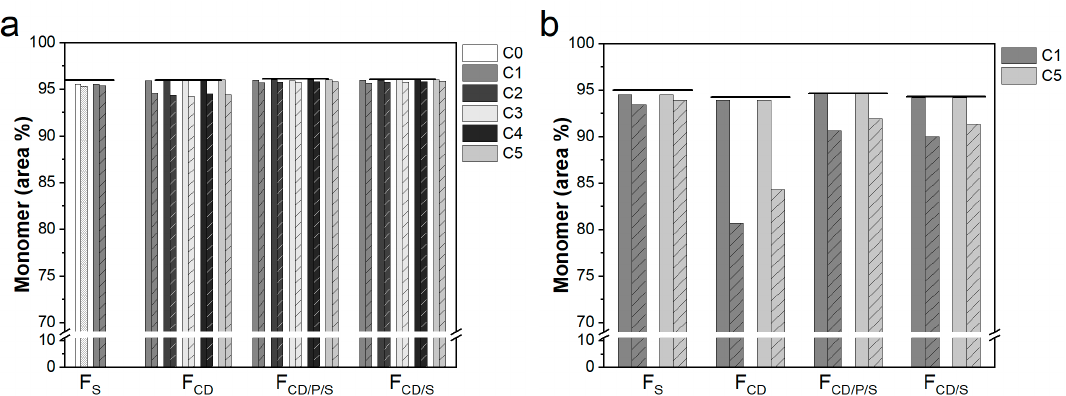
Figure 6. Protein stability by size-exclusion high-performance liquid chromatography (SE-HPLC). Percentage of remaining monomer for ( a ) 10 mg/mL mAb formulations and ( b ) 50 mg/mL mAb for different formulations and freeze-drying cycle conditions. Bars without pattern show monomer content directly after freeze-drying and bars with pattern show monomer content after storage at 40 °C for 3 months. Lines show the monomer content of the liquid formulation prior to freeze-drying.